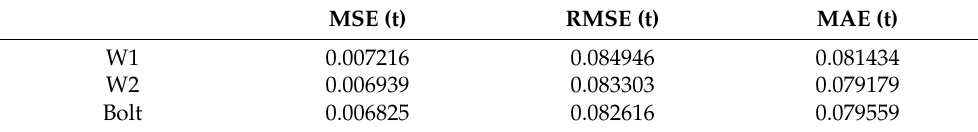
Table 7. Translation accuracy of real objects in railway transportation.